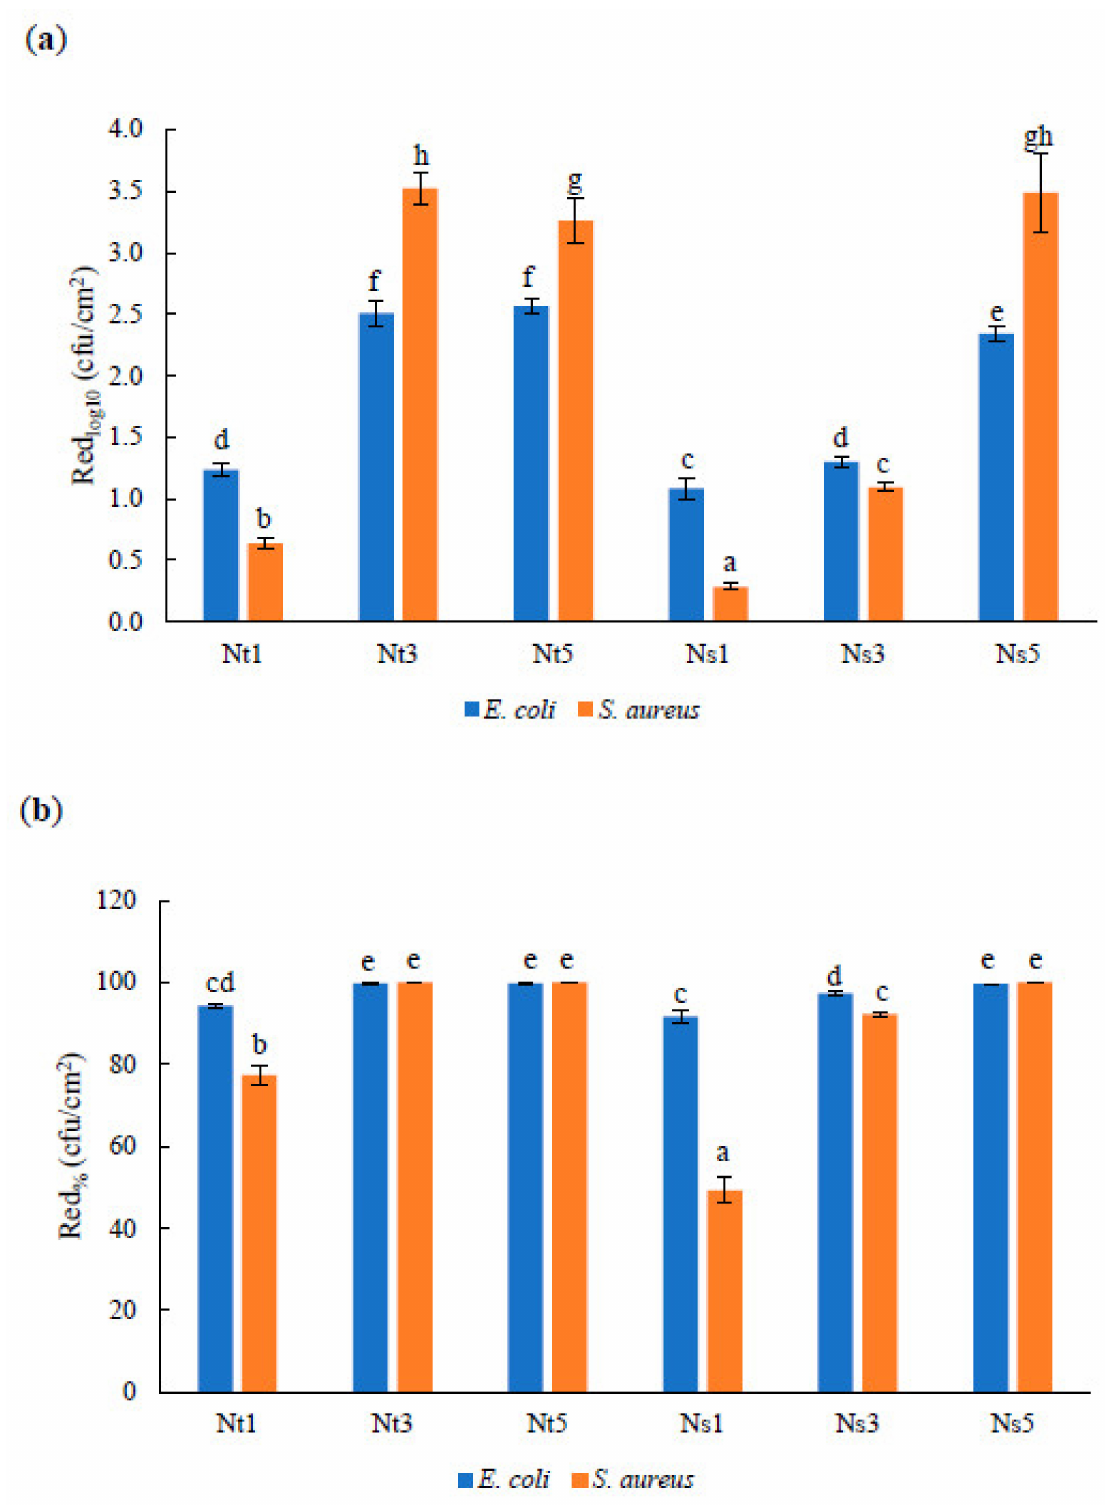
Figure 2. Antimicrobial activity (R) values of samples containing biocides relative to control sam- ples (without biocide): ( a ) reduction in the decimal logarithm cfu/cm 2 (Red log10 ), ( b ) percentage reduction cfu/cm 2 ; all R values are statistically significant in relation to control samples. Statistically significant differences between the variants in the graph are marked with different letters, for p < 0.05. Abbreviations: as in Figure